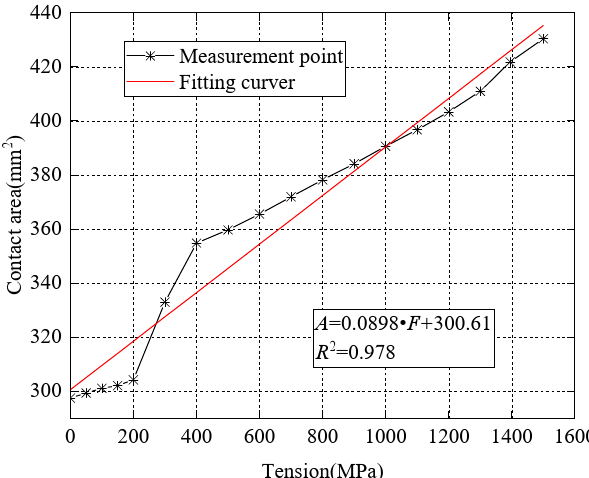
Figure 8. Contact area between steel strand and wedges.